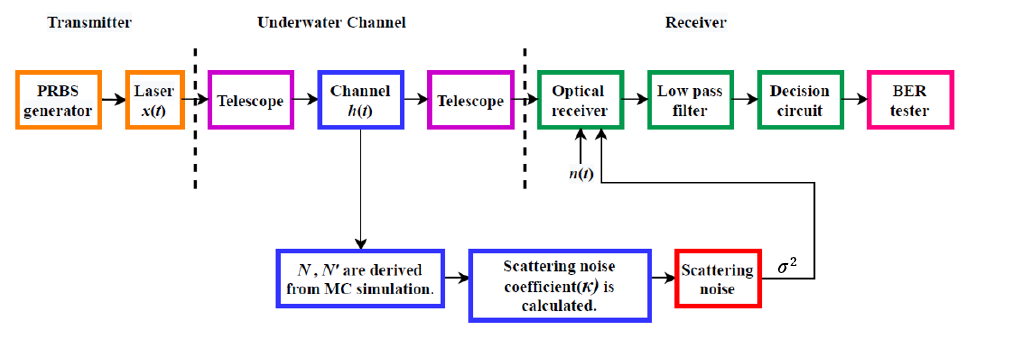
Figure 1. System